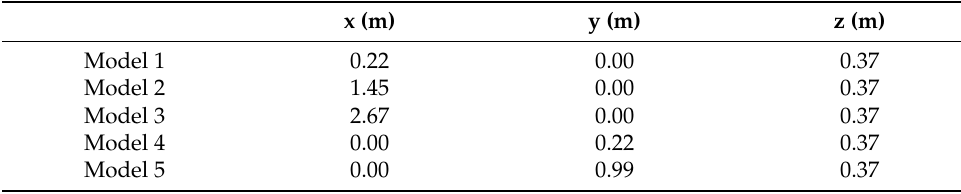
Figure 1. The schematic of the simplified model of a fuel cell bus (m). Table 1. The center coordinates of the leakage positions.